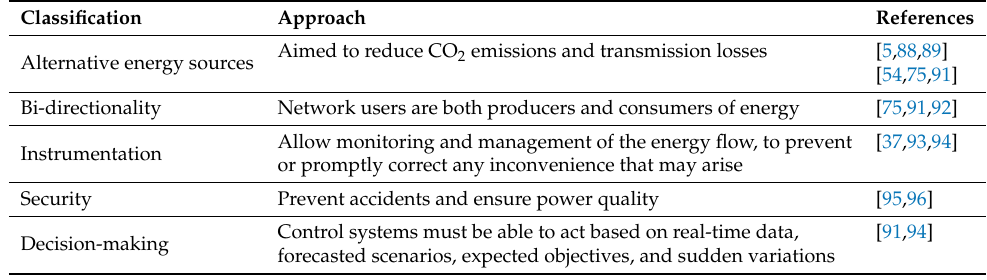
Table 2. Different approaches to Smart Grid.